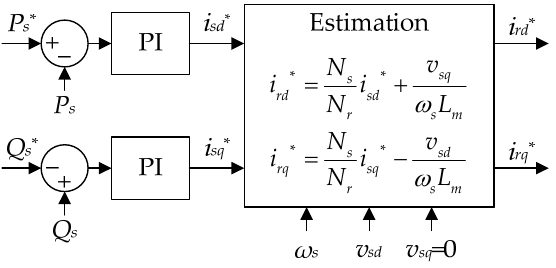
Figure 3. Block diagram of the conventional decoupled Active and reactive powers (P ‐ Q) control.